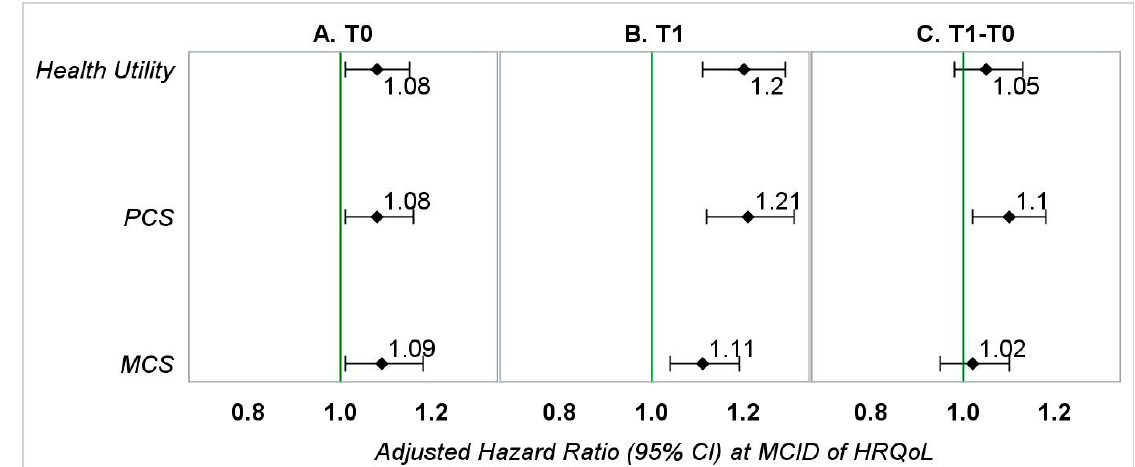
Figure 2. Adjusted hazard ratios (95% CI) representing the association between HRQoL (at MCID) and OS in patients with kidney cancer—main analyses. PCS—physical component summary; MCS—mental component summary. ( A ) Hazard ratios represent the association between baseline HRQoL (0.03-point or 3-point reduction) and overall survival adjusted for gender, race, education (T0), marital status (T0), annual household income (T0), smoking status (T0), geographic region, number of comorbid conditions (T0), age at diagnosis, stage of kidney cancer at diagnosis, tumor grade, treatment type, and months between the T0 survey and kidney cancer diagnosis. ( B ) Hazard ratios represent the association between follow-up HRQoL (0.03-point or 3-point reduction) and overall survival adjusted for gender, race, education (T1), marital status (T1), annual household income (T1), smoking status (T1), geographic region, number of comorbid conditions (T1), age at diagnosis, stage of kidney cancer at diagnosis, tumor grade, treatment type, and months between diagnosis of kidney cancer and the T1 survey. ( C ) Hazard ratios represent the association between change in HRQoL (0.03-point or 3-point reduction) from baseline to follow-up and overall survival adjusted for gender, race, education (T1), marital status (T1), annual household income (T1), smoking status (T1), geographic region, number of comorbid conditions (T1), age at diagnosis, stage of kidney cancer at diagnosis, tumor grade, treatment type, months between the T0 survey and kidney cancer diagnosis, and months between diagnosis of kidney cancer and the T1 survey.